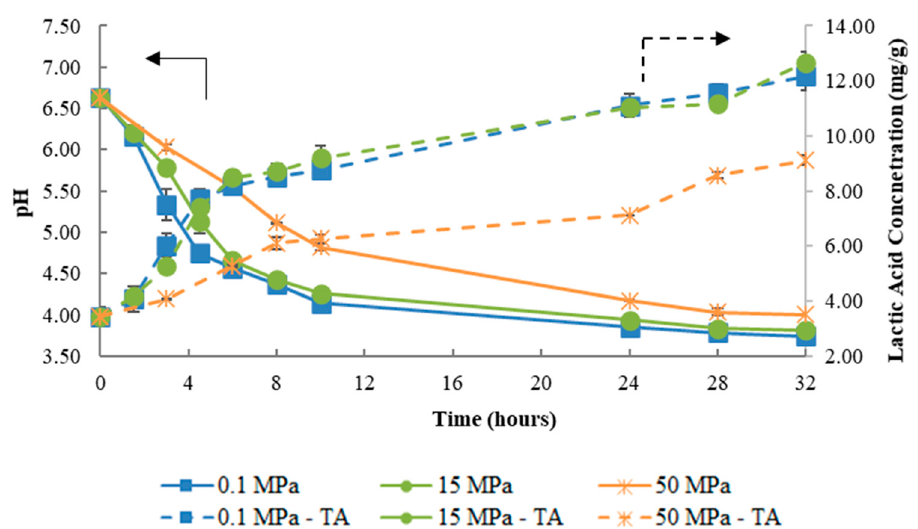
Figure 3. Variation of pH (solid lines) and titratable acidity (TA (broken lines), expressed as lactic acid concentration, mg/g), during fermentation under 0.1, 15, and 50 MPa at 32 °C.